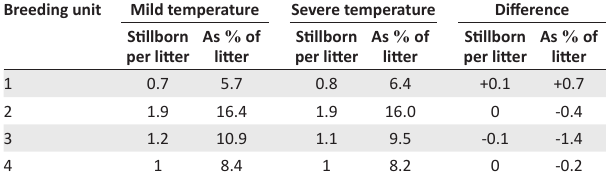
TABLE 4: Average number of stillbirths with farrowing at mild and severe temperatures. Breeding